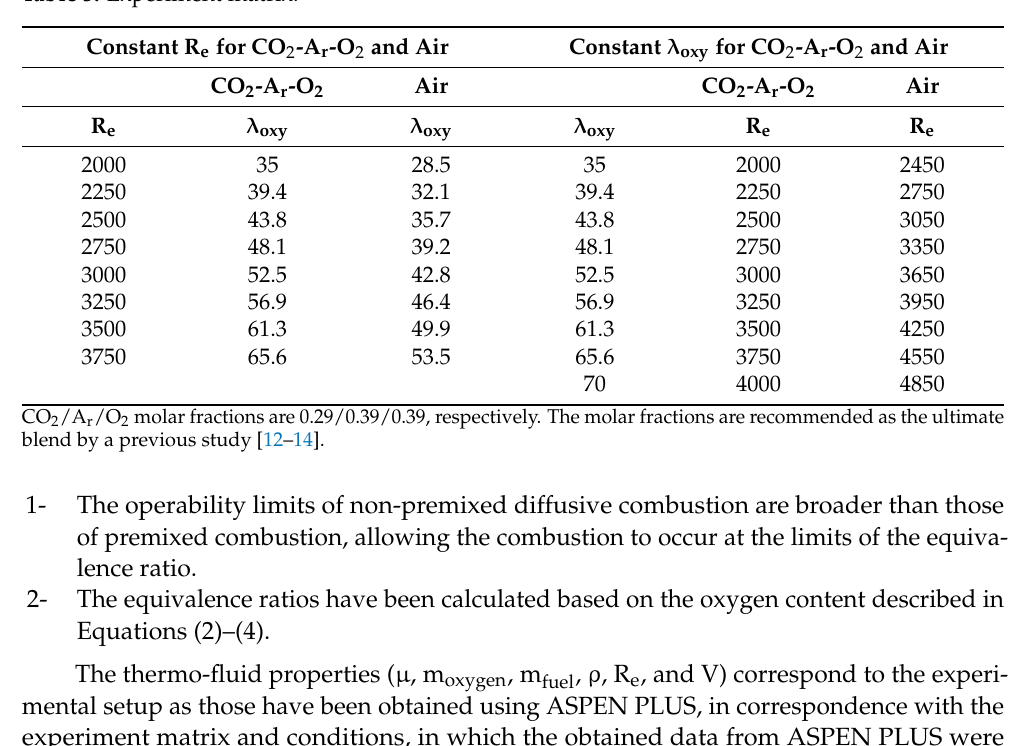
Table 3. Experiment